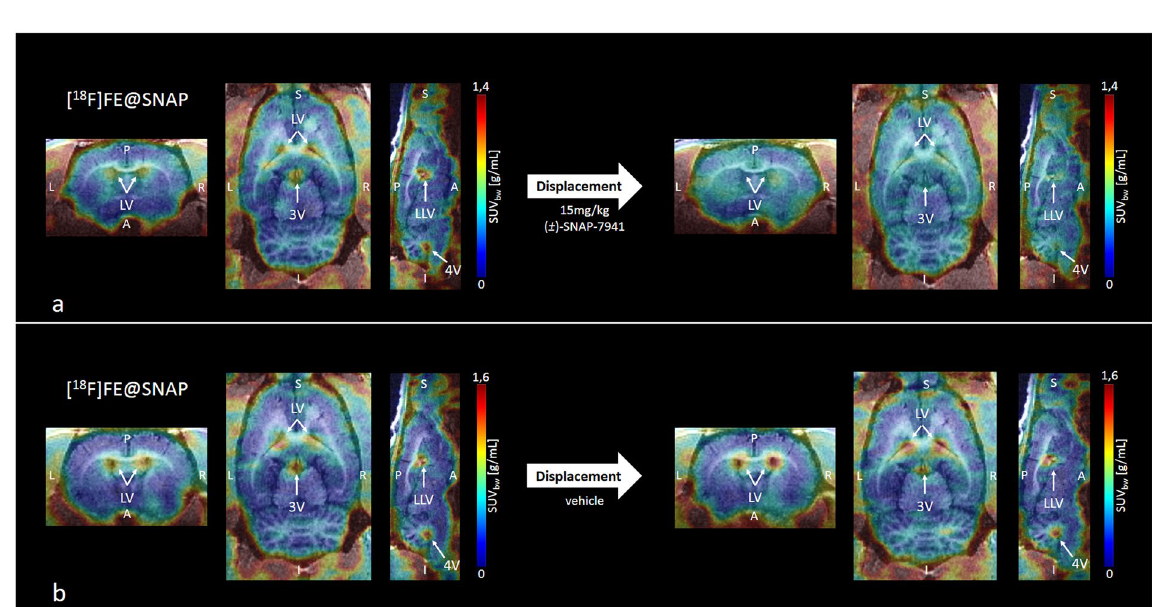
Figure 3. Small-animal PET/MR brain images of [ 11 C]SNAP-7941. Exemplary small-animal PET/MR images of representative coronal (left), horizontal (centre) and sagittal (right) planes of a rat brain with [ 11 C]SNAP- 7941 before and after administration of 15 mg/kg ( ± )-SNAP-7941 ( a ) and with [ 11 C]SNAP-7941 before and after administration of the corresponding vehicle ( b ). PET data are contributed to summation images from 0–15 minutes (before displacement) and from 15–45 minutes (after displacement). Anatomical structures are indicated by arrows ( LV = lateral ventricle; LLV = left lateral ventricle; 3V = third ventricle; 4V = fourth ventricle).